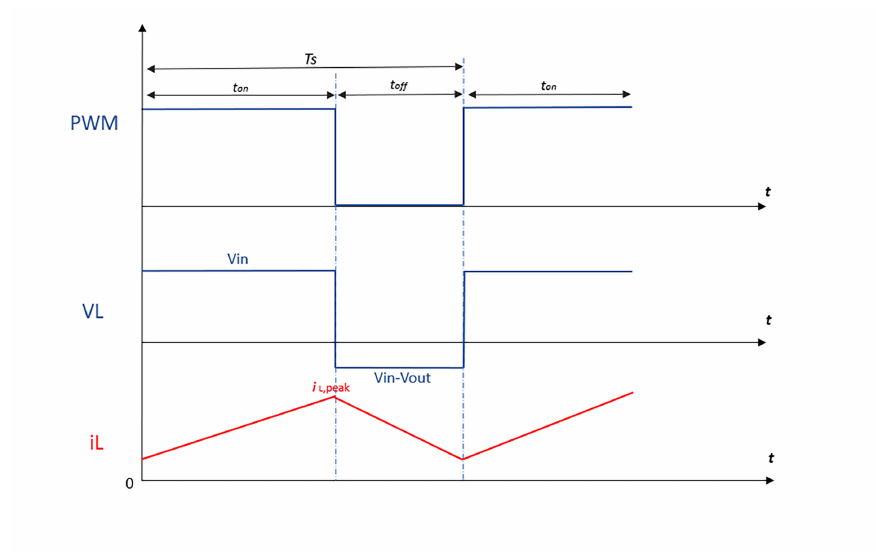
Figure 3. Inductance current and voltage signals in continuous conduction mode (CCM).